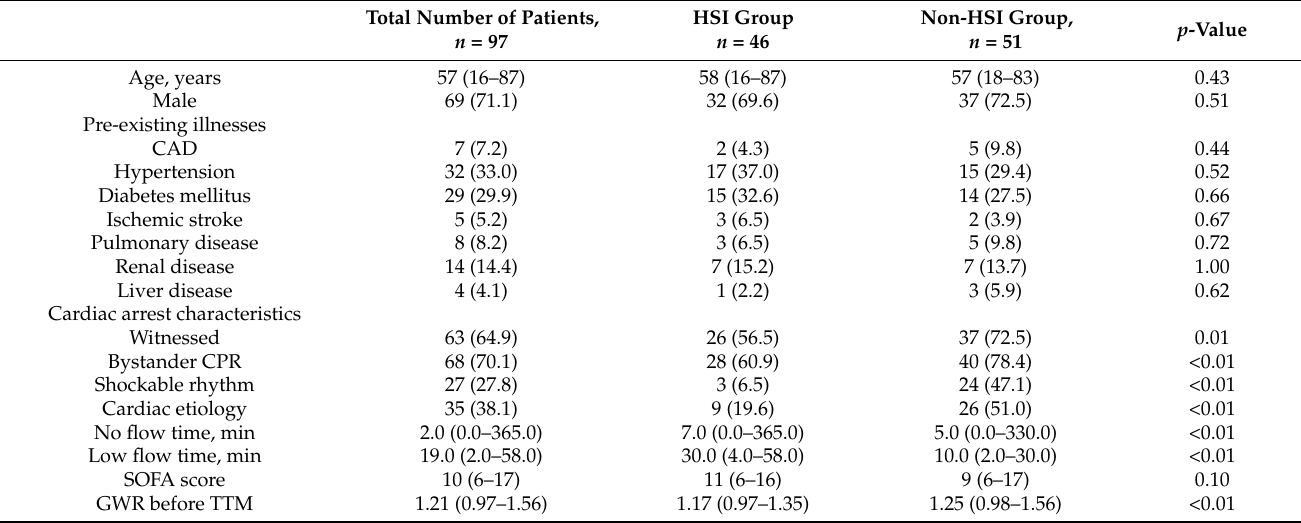
Figure 1. Flow diagram of patient inclusion. Abbreviations: return of spontaneous circulation (ROSC); Glasgow Coma Scale (GCS); magnetic resonance image (MRI); post-cardiac arrest (PCA); extracorporeal cardiopulmonary resuscitation (ECPR); intensive care unit (ICU); continuous renal replace therapy (CRRT); high-signal intensity (HSI); Cerebral Performance Categories (CPC). Table 1. Baseline demographics, characteristics, and PFs associated between HSI and non-HSI on DWI performed before PCA